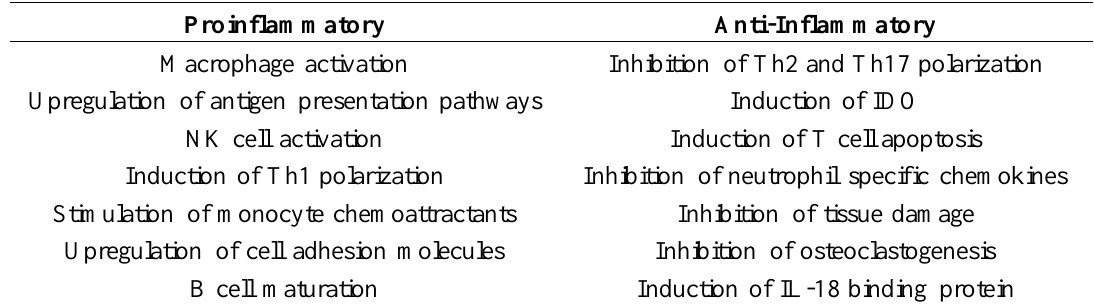
Table 1. General properties of interferon-γ in immune